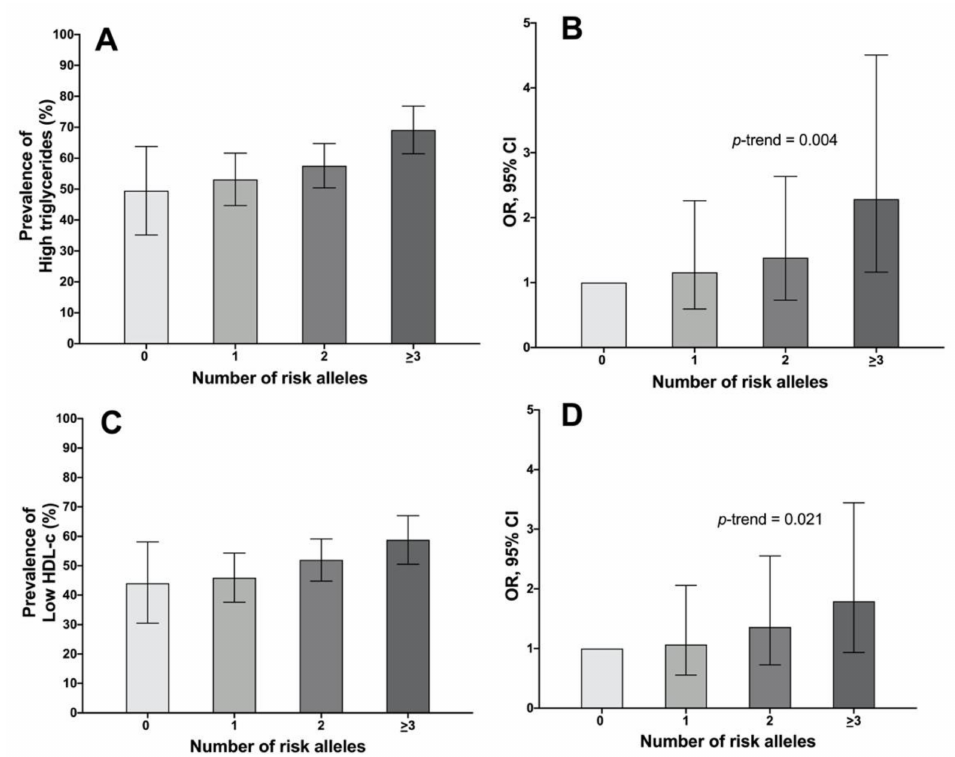
Figure 1. GRS including rs2642438-A (MARC1) , rs56371916-C (ADCY5) , and rs6564851-A (BCO1) for hypertriglyceridemia in Mexican adult men. ( A ) Prevalence of high triglycerides; ( B ) Odd ratio (OR) for high triglycerides (> 3 risk alleles OR = 2.23; 95% CI 1.13–4.42, p = 0.022), p -trend= 0.004; ( C ) Prevalence of low HDL-c levels; ( D ) OR for low HDL-c (> 3 risk alleles OR = 1.80; 95% CI 0.93–3.46, p = 0.079, p -trend= 0.021). Models adjusted for age (years), alcohol intake (g/day), smoking status (no, past, current), BMI (normal, overweight, obesity), and lipid-lowering medications (no,